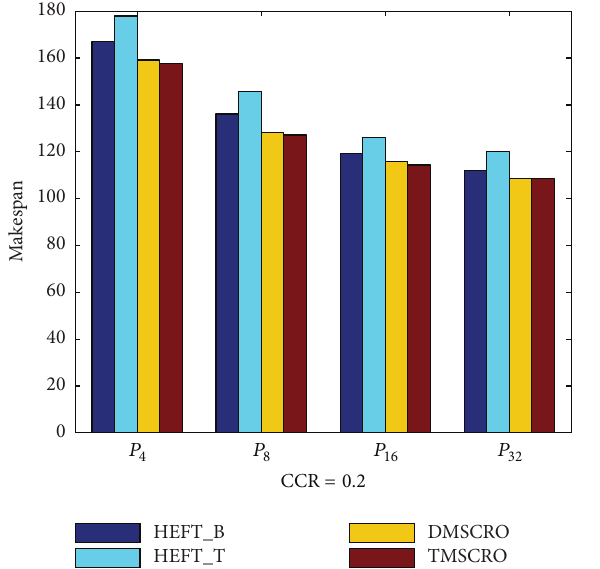
Figure 22: Average makespan of TMSCRO under different values of CCR; the number of tasks is